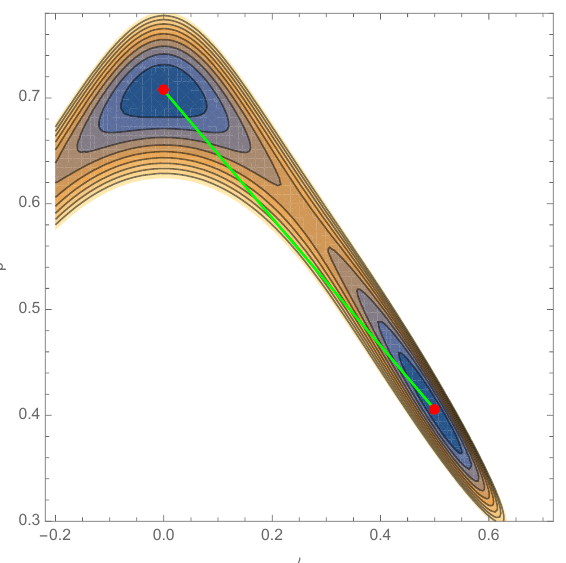
Figure 1 . The contour plot of the potential V gluon ; 4 ( L; T ) =b 4 T at ~ a c = a=T c = 2 : 237527. The green linear line links the two degenerated vacua (3.28) and (3.29) shown by the red points. The shape of the potential as a function of ‘ or p on the linear line corresponds to the black solid-line in (cid:12)gure